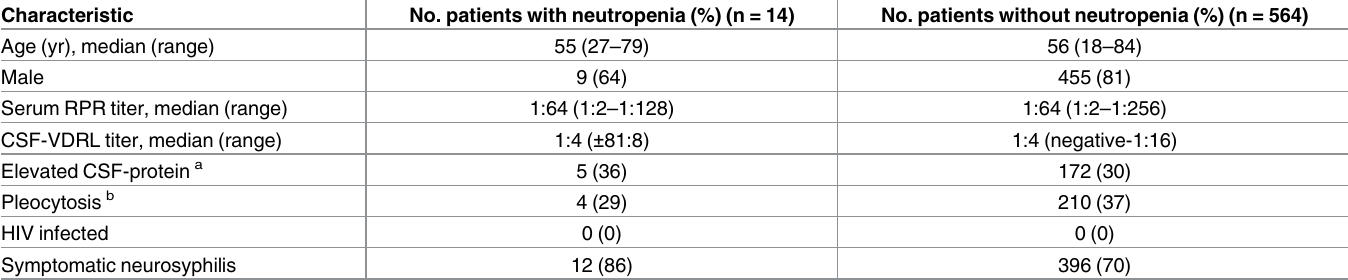
Data are number of patients (%), unless otherwise indicated. Abbreviation: RPR, rapid plasma reagin; CSF, cerebrospinal fluid; VDRL, venereal disease research laboratory; HIV, human immunodeficiency virus.